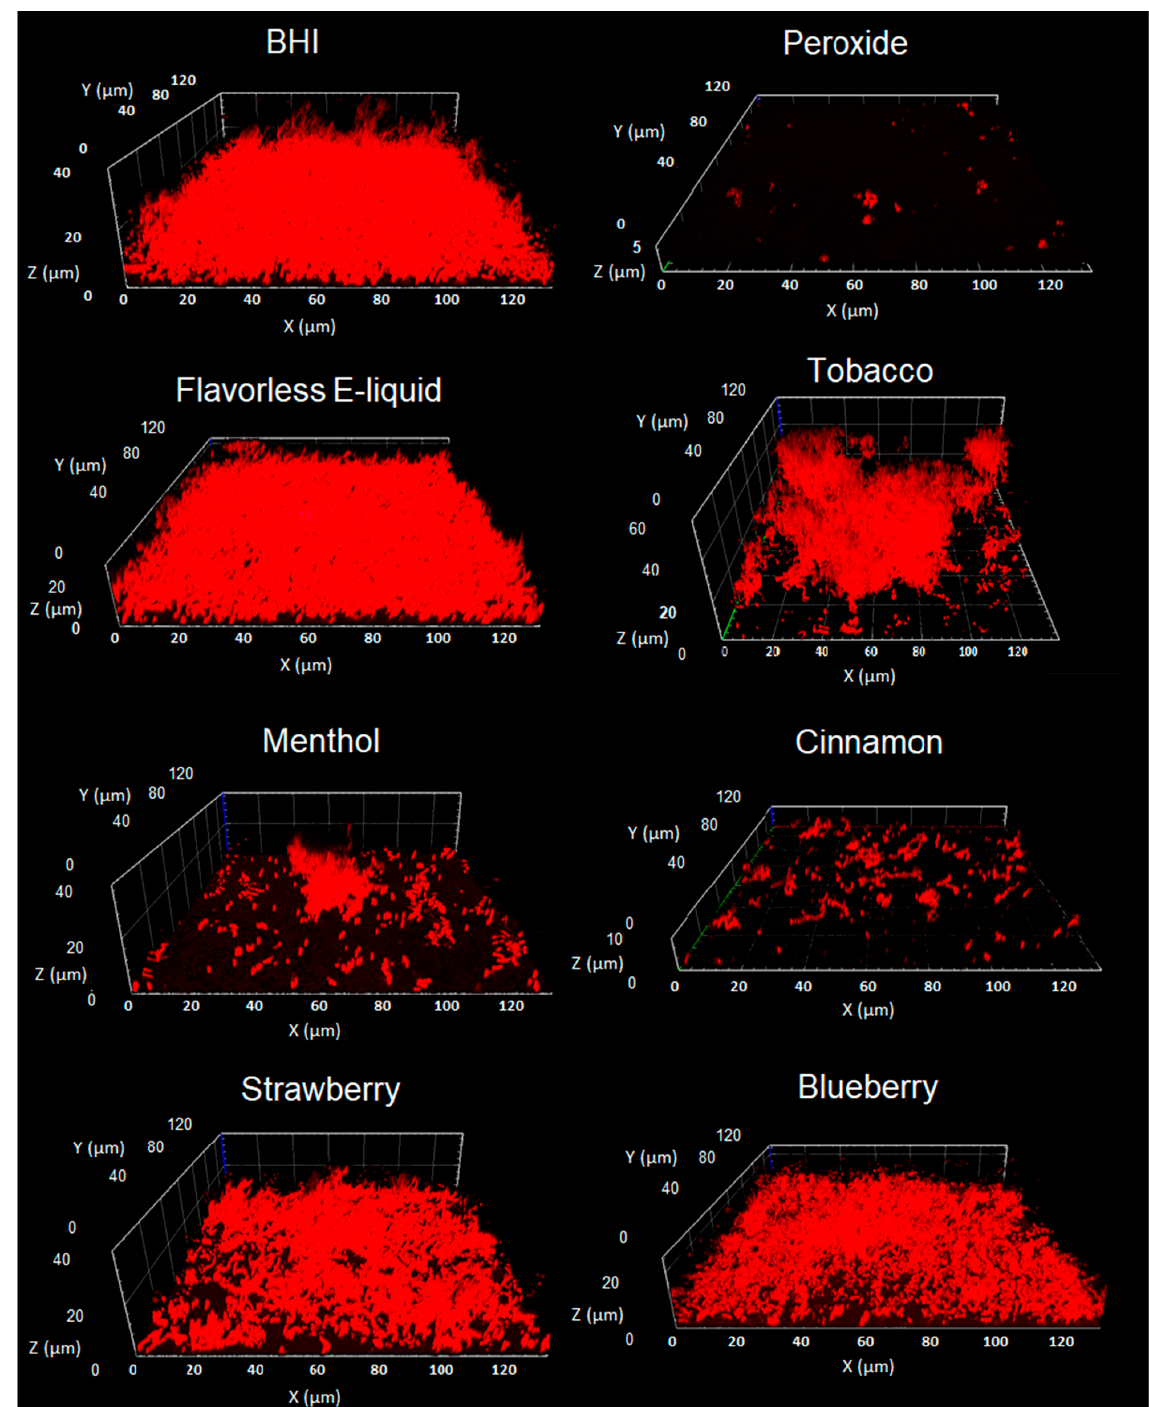
Figure 3. Effects of 3% E-liquids ± Flavors on Multi-Species ( S. gordonii , S. intermedius , S. mitis, and